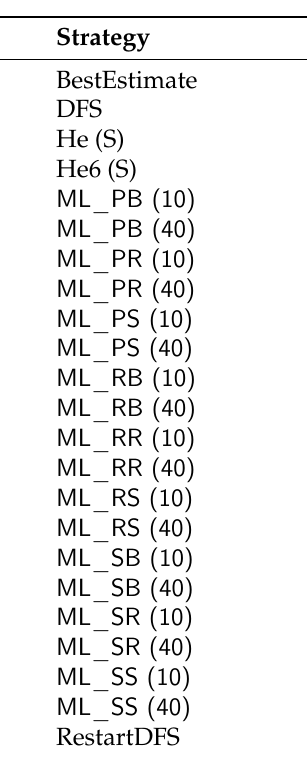
Table A1. Maximum independent set instances: average solving time and explored nodes for